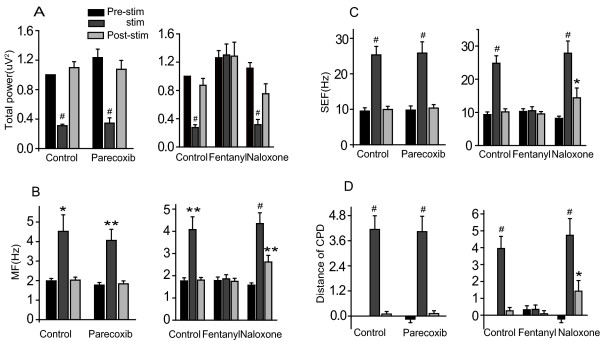
The effect of parecoxib and fentanyl is evaluated by EEG parameters. Total power (A) was decreased during nociceptive stimulation, while MF (B), SEF (C), and the distance of cumulative power distribution (CPD) increased in response to noxious stimulation(D). Fentanyl (n = 12) significantly inhibited the response in each case and the inhibition was reversed by naloxone (n = 9). Parecoxib had no effect on the neuronal response to noxious stimulation (n = 11). Total power and distance of cumulative power distribution was normalized to pre-stimulation values. *P < 0.05, **P < 0.01, #P < 0.001, compared with pre-stim value.